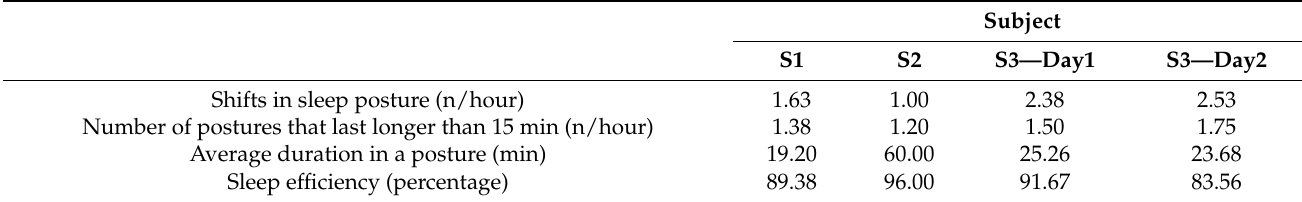
Table 16. Sleep indicators of subjects.